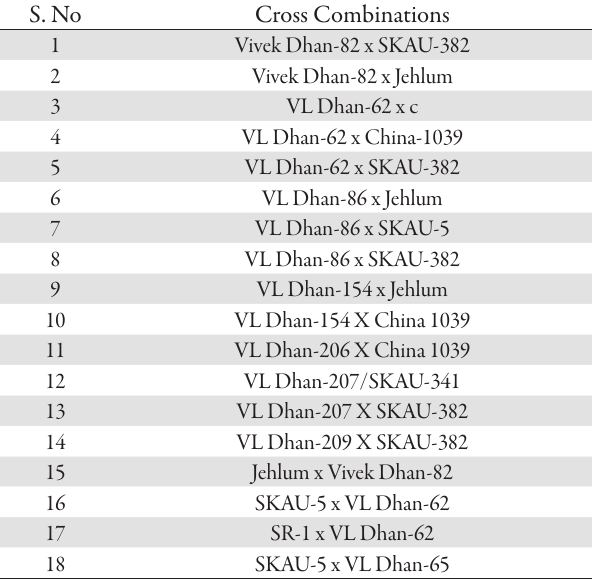
Tab. 1. Cross combination of F experimental